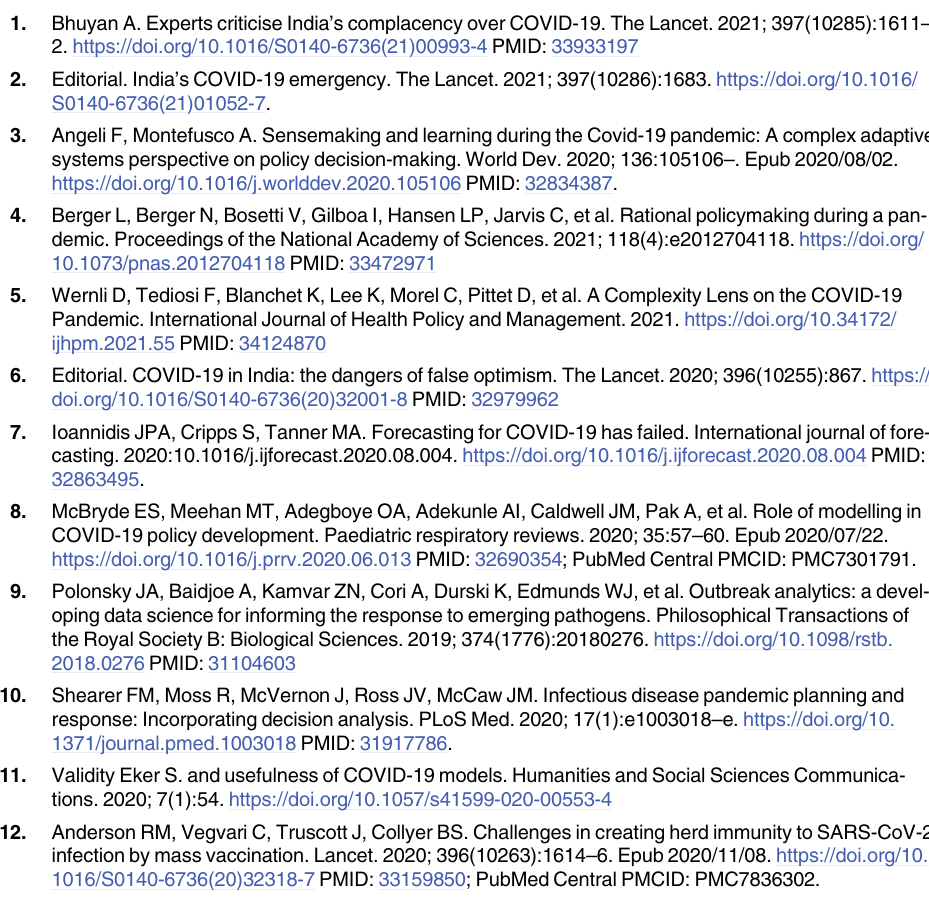
S1 Table. A summary of the social measures applied by each Indian state from May 2021 – August